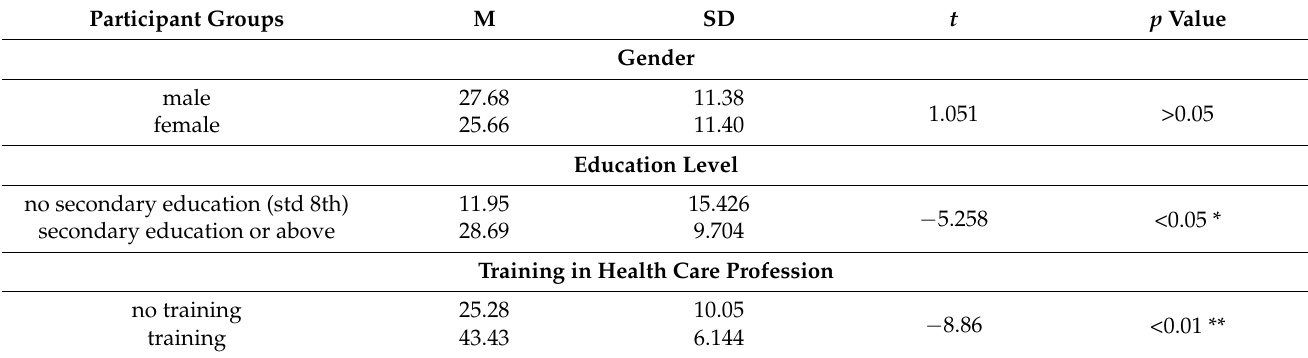
Table 3. Standardized health literacy (HL) index scores for subgroups of